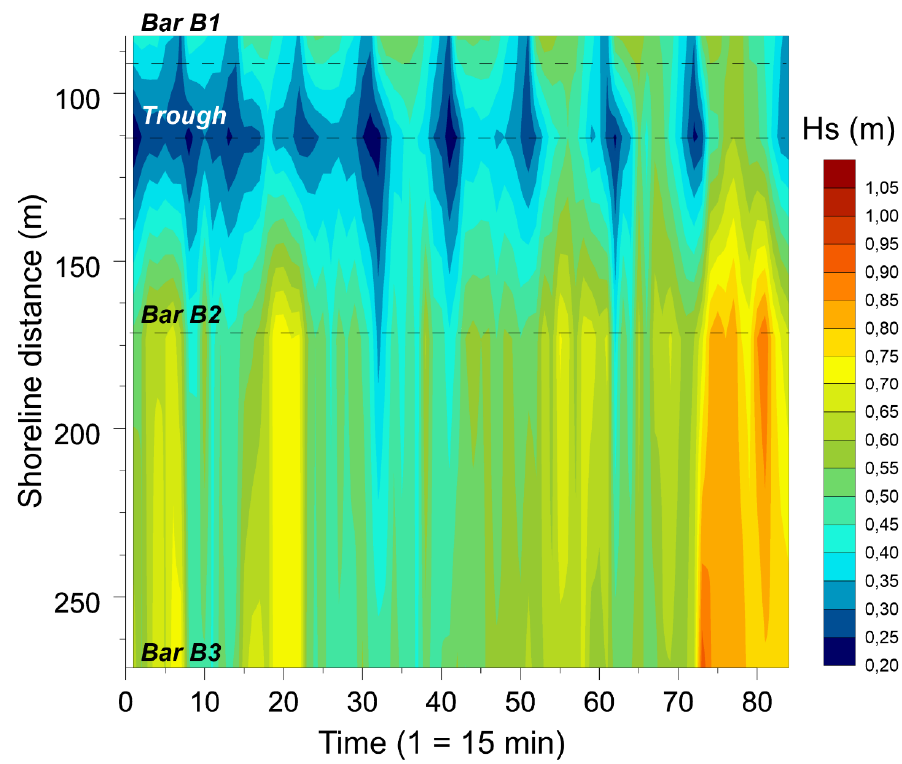
Figure 4. Stacked burst records of significant wave height recorded at high tide showing changes in wave height across the intertidal zone. Wave height was measured on each intertidal bar and in the trough on the upper beach (locations are indicated by dashed lines). The horizontal axis does not correspond to a continuous time-series, but to the numbers of successive 15 min burst records obtained at high tide from 2 to 8 June 2013.